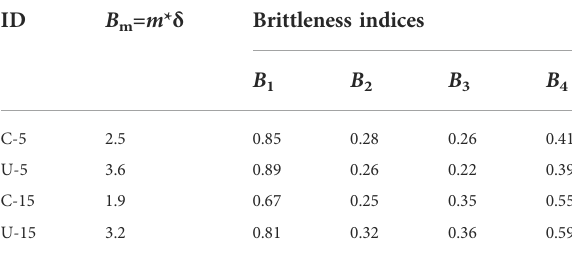
TABLE 4 Calculation results of brittleness index for granite under different loading modes. ID B m = m *